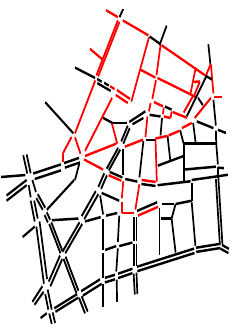
Figure 5. Snake computed on the network of the sixth district of Paris. The number of links in the snake is equal to